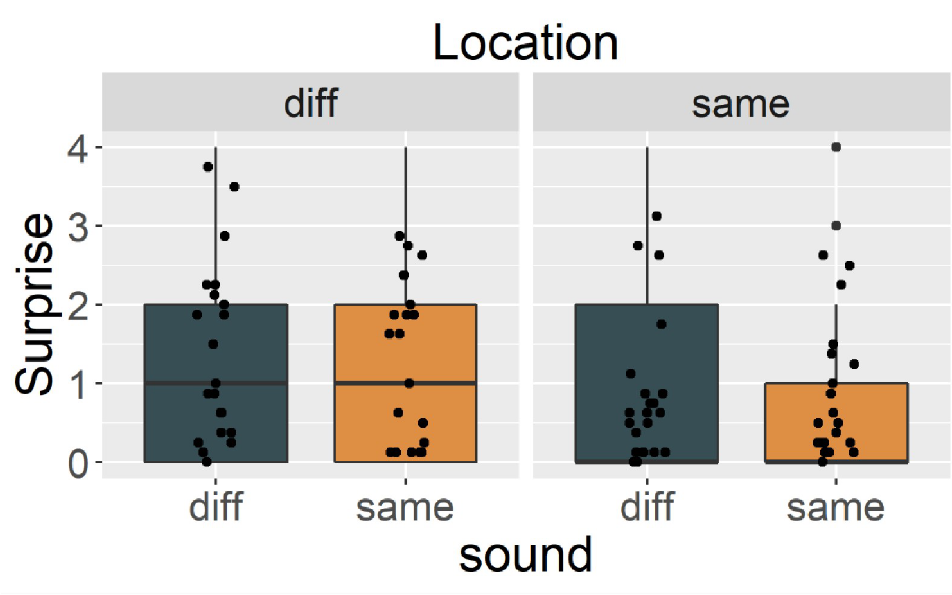
Fig 5. The magnitude of subjects’ surprise rated by eight blind raters in Exp.3. Black blue bar represents Diff sound . Orange bar represents Same sound . Left panel represents Diff location and right panel represents Same location . Each point represents mean magnitude of surprise for each trial.